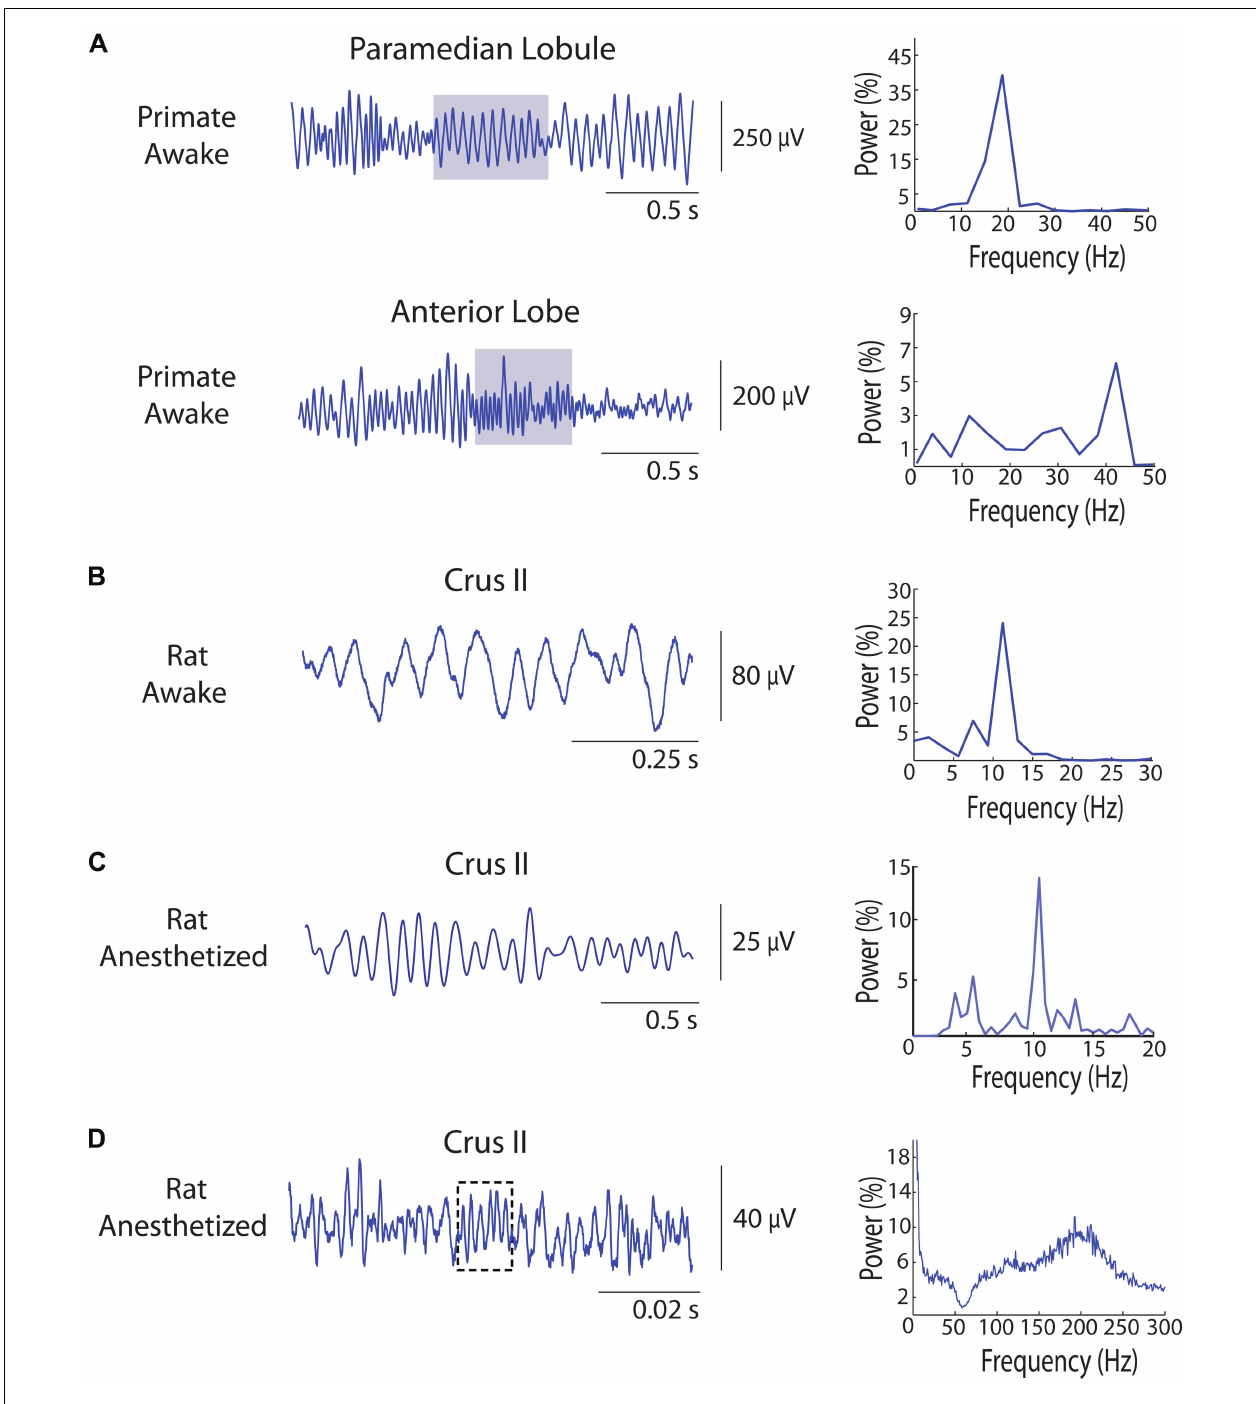
(B) Recording of LFP oscillations in the awake rat cerebellar cortex GCL. In this sample, the signal oscillates around 10.5 Hz, FFT on the whole trace. (C) Recording of LFP oscillations in the urethane-anesthetized rat cerebellar cortex GCL. Oscillations are here around the same frequency, at 11 Hz, FFT on the whole trace. (D) Recording of fast LFP oscillations in the urethane-anesthetized rat cerebellar cortex, using differential metal microelectrodes separated by 500 μ m, with at least one tip located approximately in the Purkinje cell layer. A 312 Hz short 6-cycle episode is highlighted. FFT averaged on 120 2-s windows, so for the whole 2